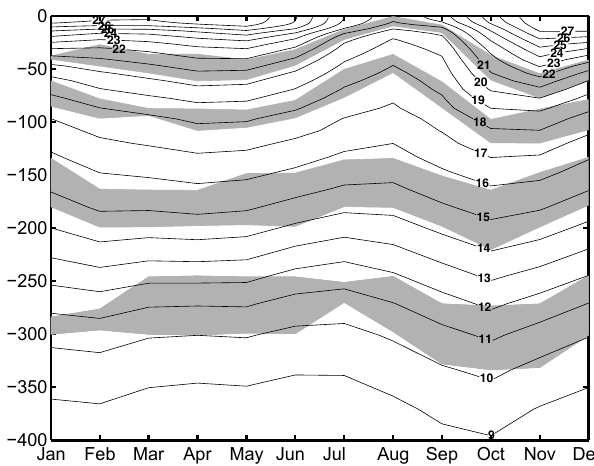
Figure 6. Time–depth representation of TROP025 climatological temperature ( ◦ C) at 4 ◦ N–5 ◦ W over the period 1982–2012. This figure should be compared with the climatological cycle observed at the same location between 1957 and 1964 (Picaut, 1983, his Fig. 15b). To evaluate uncertainty 24 model climatologies were computed using 8-year averaging periods as in the observations (with starting years from 1982 to 2005); the shallowest and deepest positions of four isotherms (11, 15, 18, and 21 ◦ C) over this en- semble are shown with gray shading and indicate the limited role played by interannual variability, particularly for the 18 and 21 ◦ C